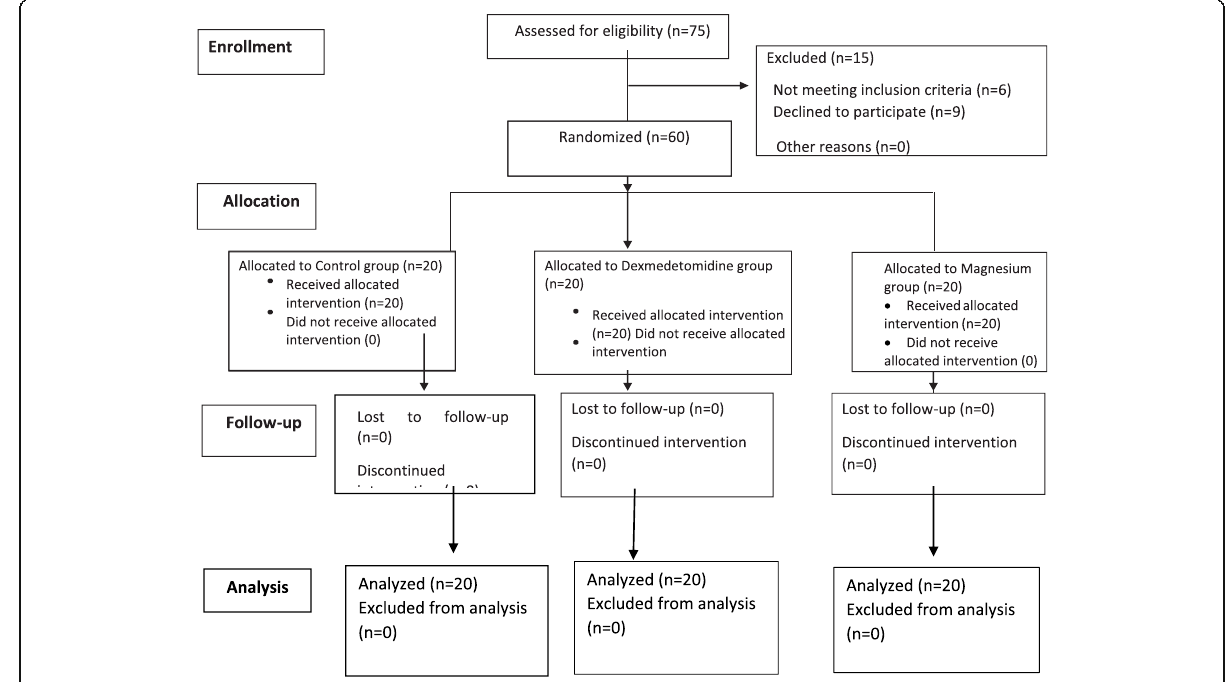
Fig. 1 CONSORT flow chart of participants at each step of the randomized study